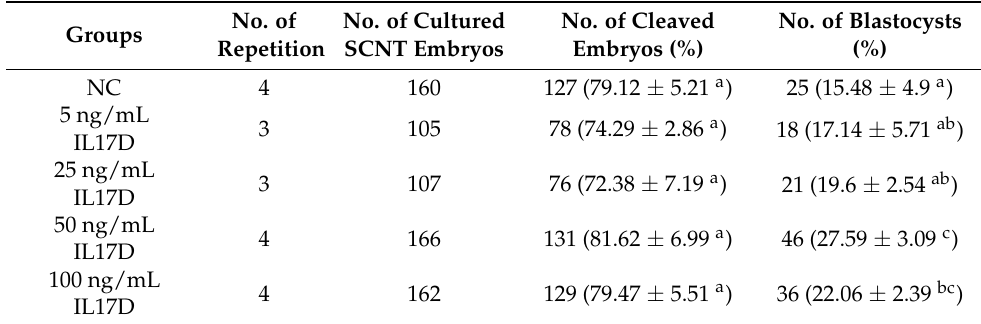
Table 3. Developmental efficiency of SCNT embryos treated with IL17D at 1-cell stage for 48